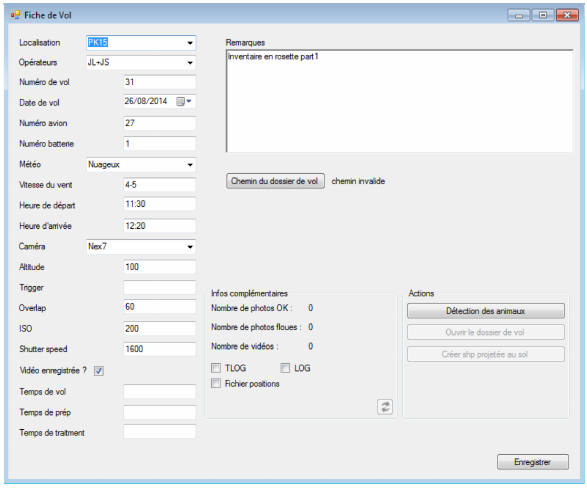
Figure 4. Flight window used to include information about the flight (weather conditions, camera settings, flight time, …). Access links to data and log files must be provided in the window. Buttons on the bottom right side open feature detection and shapefile creation of the sampling